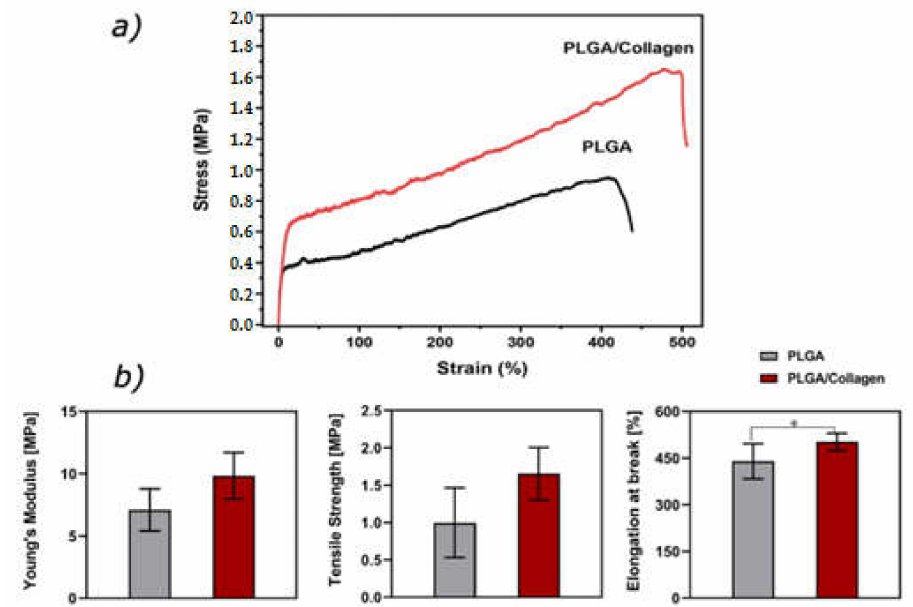
Figure 8. Mechanical analysis of PLGA and PLGA/collagen electrospun fibers ( a ). Strain-Stress curve and ( b ) Statical analysis of Young’s modulus, Tensile strength, and elongation at break of PLGA and PLGA/collagen scaffolds. (* denotes a significant difference with a value p < 0.05) ( n =